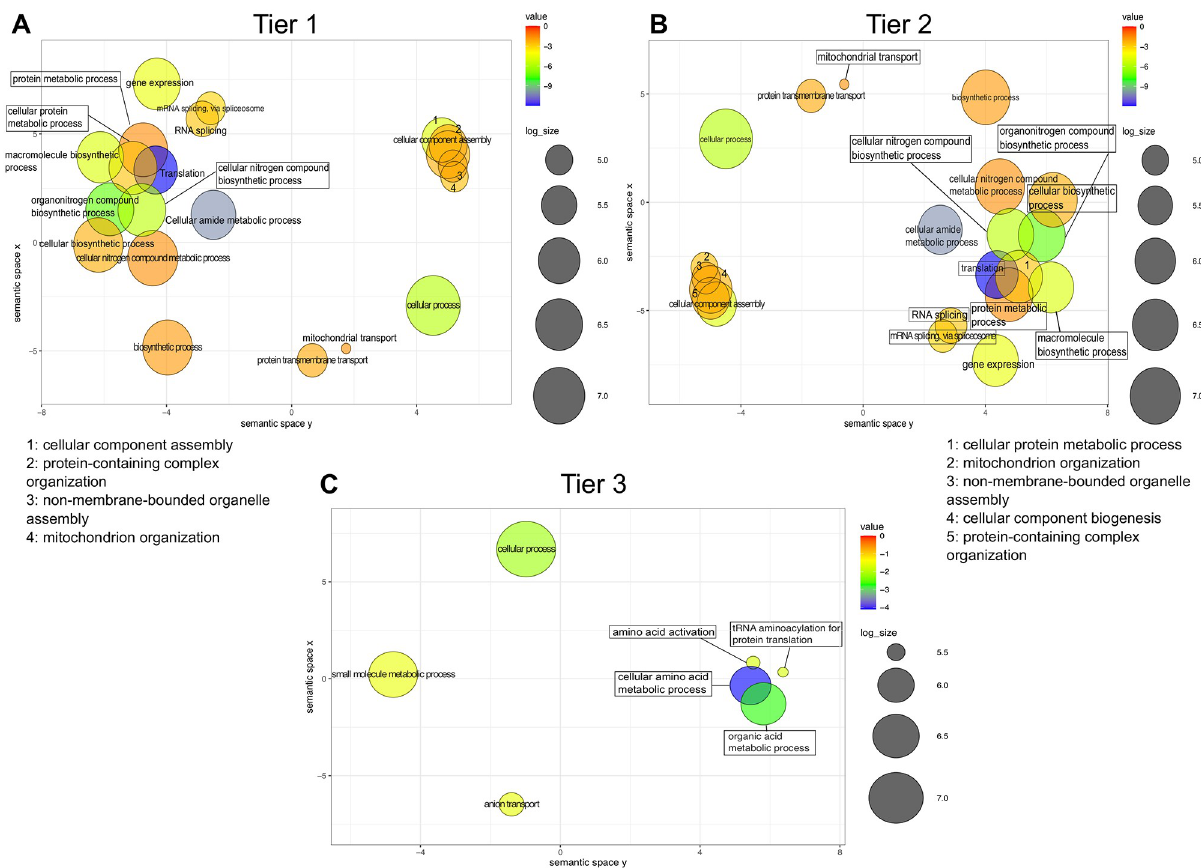
Fig 3. GO terms enrichment scatterplot for protein coding transcripts, tier 1 to 3. All plots represent the GO enrichment provided by REVIGO for (A) tier 1, (B) tier 2 and (C) tier 3. Detailed values are available in S3 Table. Each GO term is represented by a numbered circle on the plot, with placement indicating its similarity to nearby GO terms. The colour scale represents the adjusted p-value of the GO term and the size of each circle represents the log10 of the number of annotations per GO term.